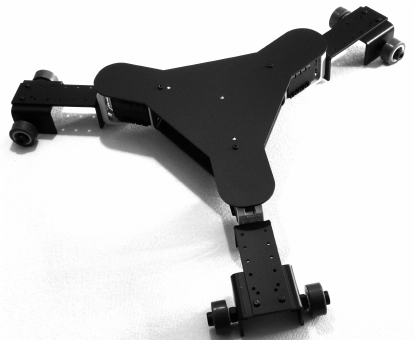
Figure 2. Trident snake robot: physical model. Figure 3. Motion path in XY plane: egalitarian solution (left) and prioritarian solution (right).